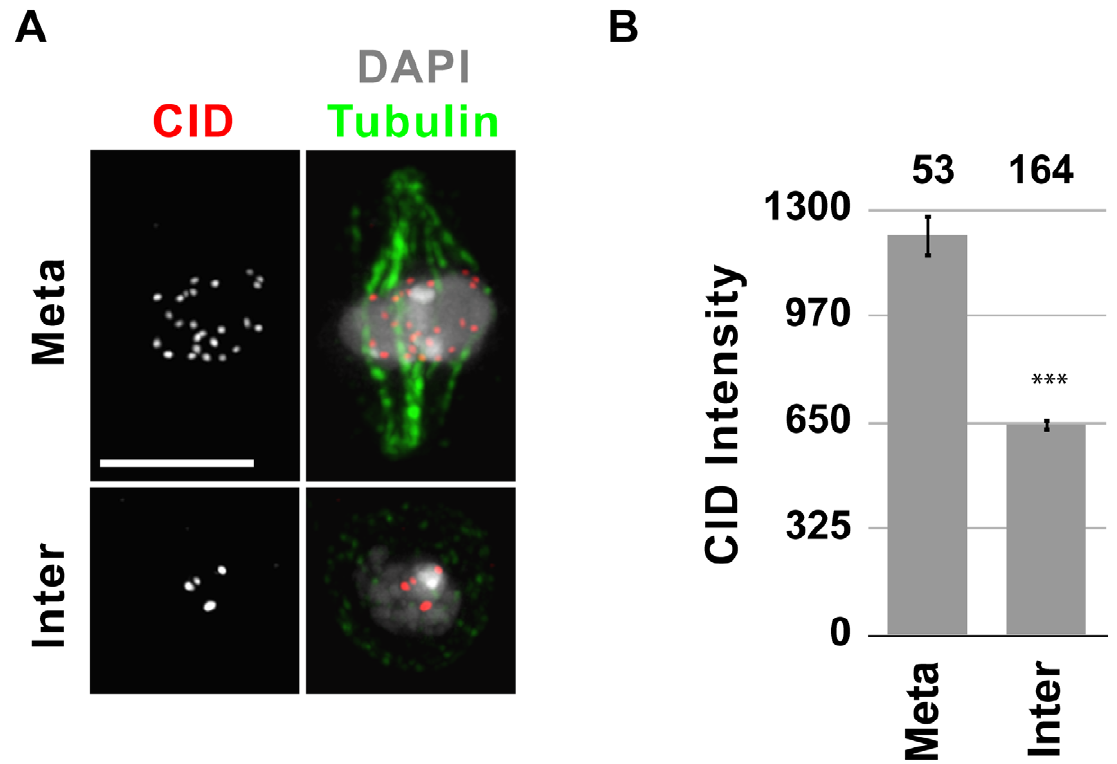
Figure 3. Metaphase cells contain double the amount of CID compared to interphase cells. A) Representative IF images of metaphase (meta) and an interphase (inter) cells stained with CID (red) and tubulin (green) antibodies, and DAPI (gray). Bar=5 m m. B) Quantification of CID intensity. Total CID intensity was measured for individual cells and the mean CID intensity is shown in the graph. The number of cells quantified is shown above the graph. *** p , 0.001 (paired T-test); error bars represent standard